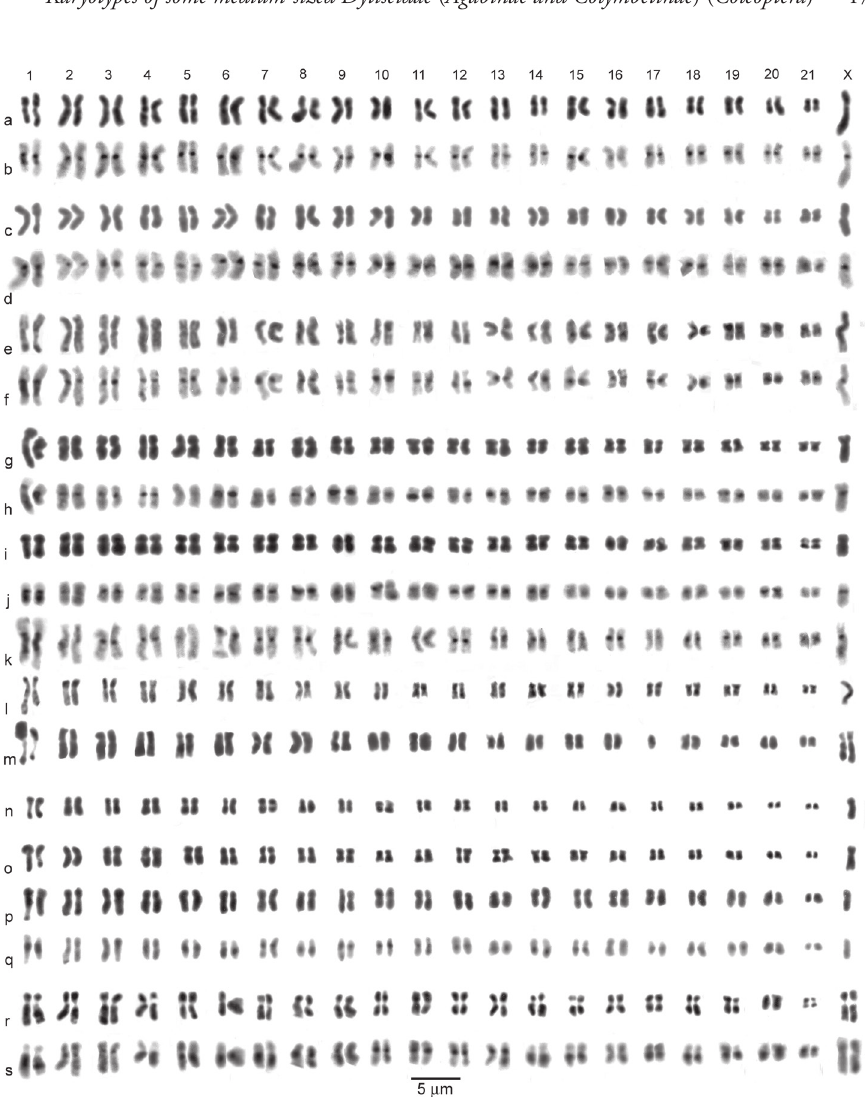
Figure 3. Agabus ( Gaurodytes ) part 1, the A. bipustulatus group, mitotic chromosomes arranged as karyotypes. a – f A. bipustulatus : a–d ♂ , Inari, testis a plain b the same nucleus C-banded c plain d the same nucleus C-banded e , f ♂ , Woolmer, mid-gut e plain f the same nucleus C-banded g – k A. bipustulatus var. solieri : g, h ♂ , Moiry, testis g plain h the same nucleus C-banded i–j, k Illsee, ♂ , testis i plain j the same nucleus C-banded k a different nucleus C-banded l , m A. nevadensis , Sierra Nevada, mid-gut, plain, l ♂ , m ♀ n , o A. wollastoni , ♂ , Madeira, testis, plain; p–s A. melanarius : p , q ♂ , testis p plain q the same nucleus C-banded r , s ♀ , ovary, r plain, s the same nucleus C-banded. Bar = 5